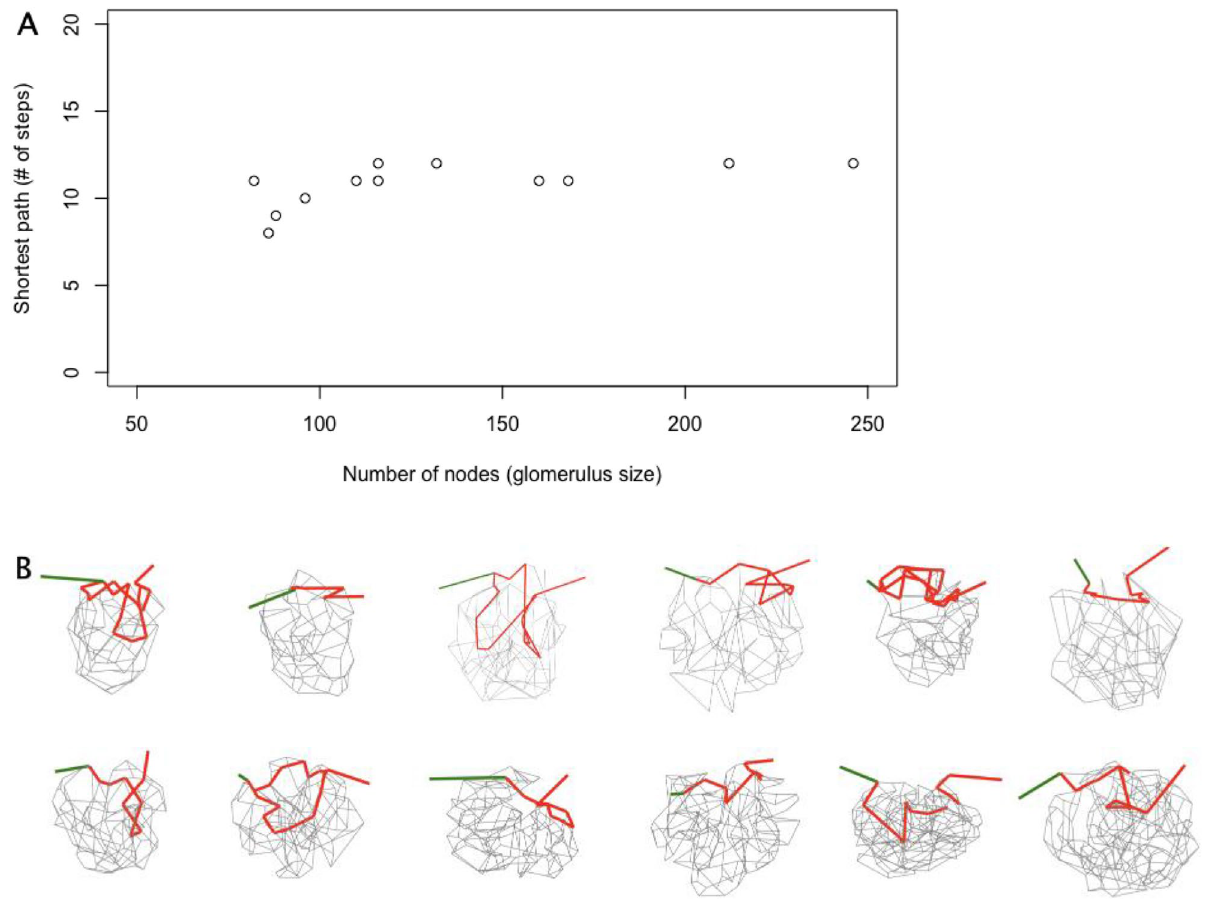
Figure 5. Shortest path versus glomerulus size. ( A ) Graph of the number of steps in the shortest path versus the number of nodes (branch points) in the glomerulus. ( B ) The glomeruli are shown in the same order as in Fig. 2, and oriented similarly with the afferent arteriole on the left colored green. The shortest path(s) (in several instances, there are two paths of the same length) from afferent to efferent arteriole is shown in red, and the other connections within the glomerulus are shown in gray. The shortest path is located on the vascular pole side of the glomerulus. These observations suggest that the shortest path is established at some point during glomerular development, after which more branches are added on the vascular pole side which create paths of longer lengths.